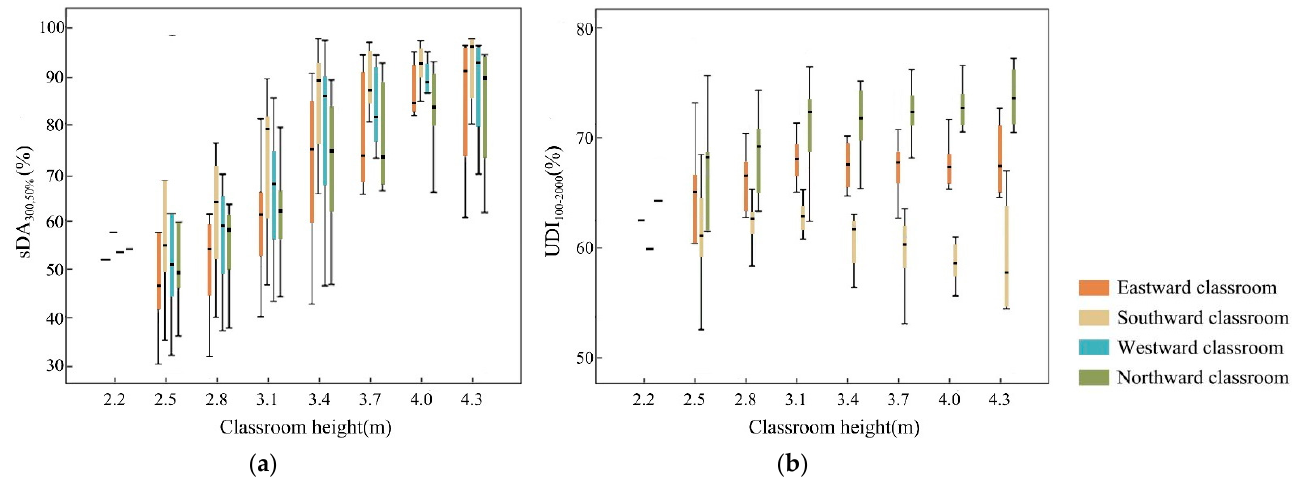
Figure 7. The analysis results of the distribution interval between the classroom height and the evaluation indices: ( a ) the analysis results of sDA 300,50% ; ( b ) the analysis results of UDI 100-2000 .